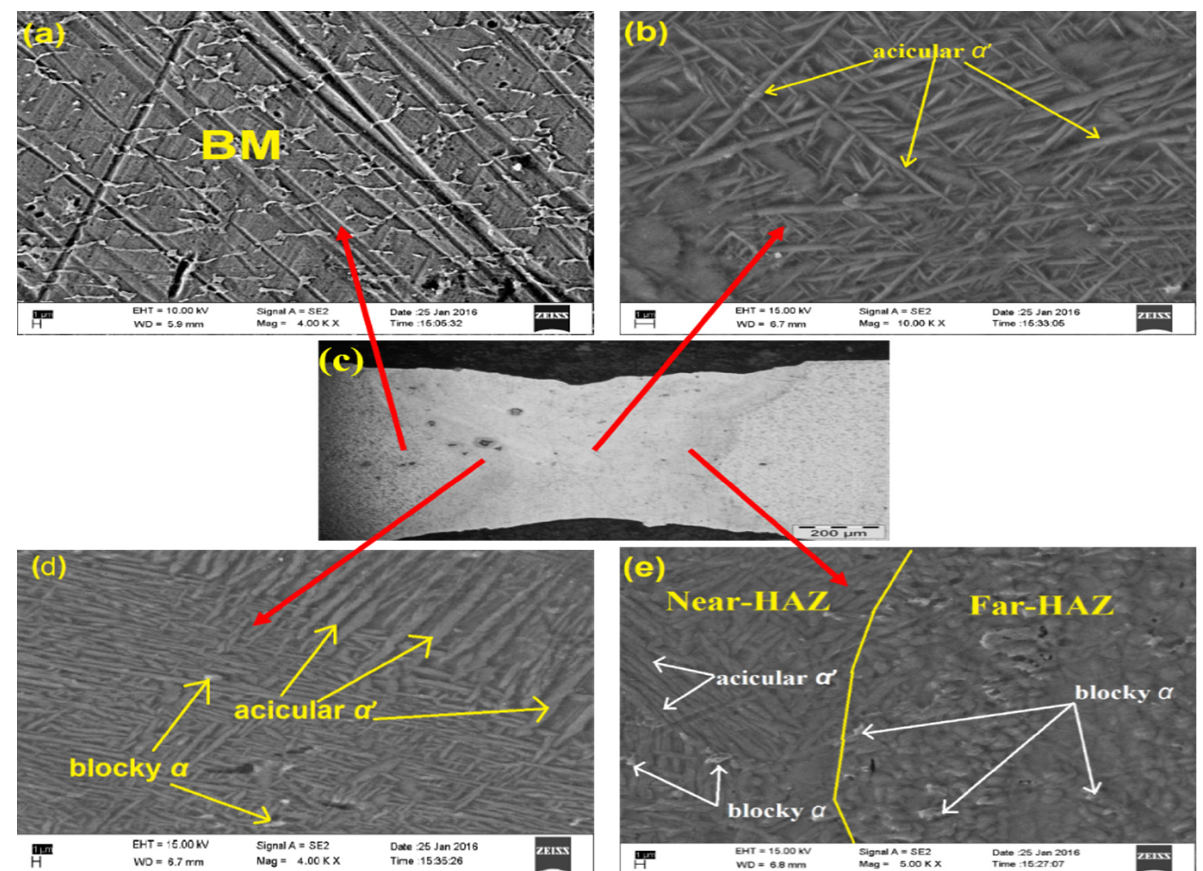
Figure 6. Joint morphology of annealed A-2 sample in ( a – e ).